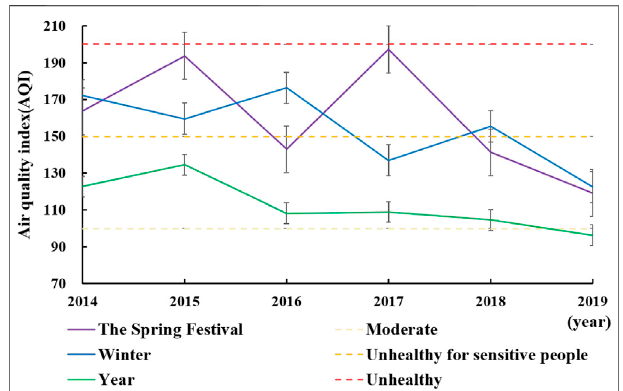
FIGURE 2 | AQI change trend of Zhengzhou during Spring Festival from 2014 to 2019.